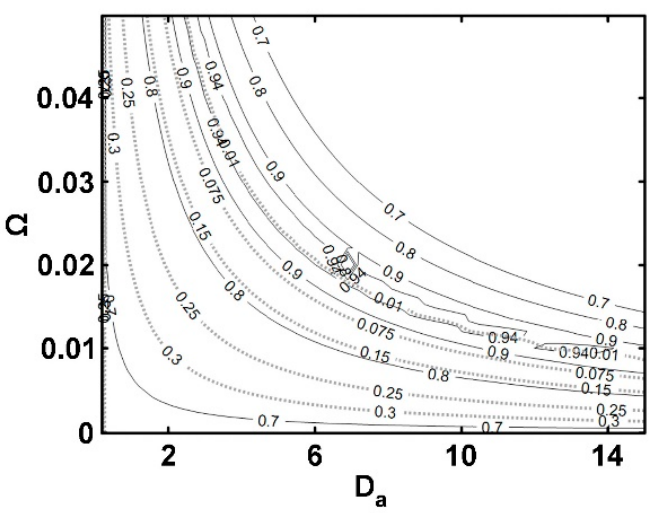
Figure 13. Design chart for IFBPVMR ( Configuration 3 ). Notes: (i) Ester yields: continuous lines, (ii) Retentate water molar fractions: dotted lines.